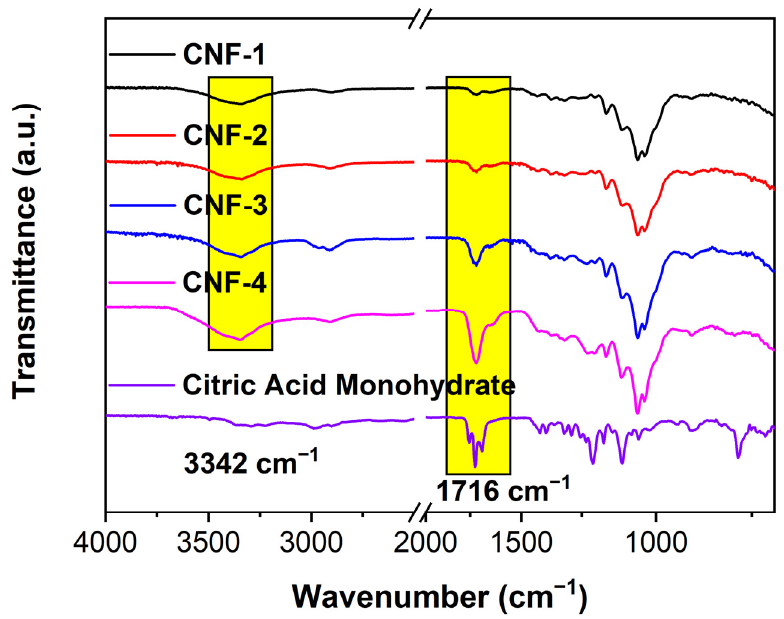
Figure 2. FTIR spectra for CNF membranes with citric acid monohydrate as reference.